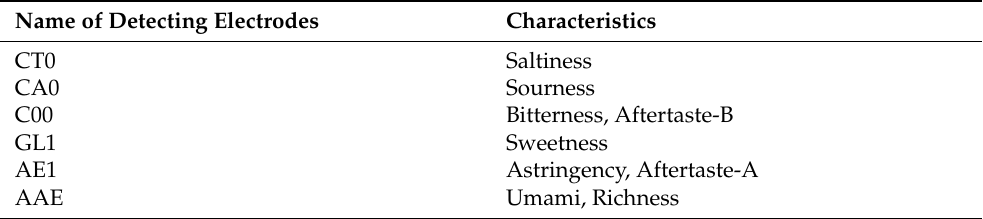
Table A2. The sensor array of the